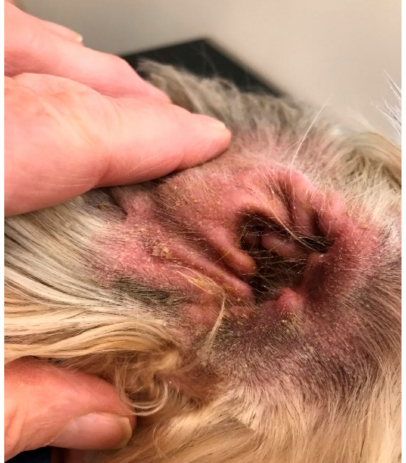
Figure 1. Standard swab and culture from the vertical ear canal of this case, for example, will yield perhaps four species of bacteria and one species of yeast. If the sample is subject to 16s rDNA sequencing, it will likely reveal in excess of 30 species of